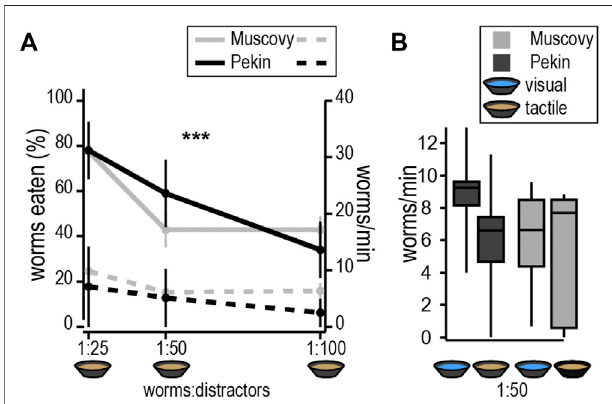
FIGURE1| Increasingdif fi cultyoftactileforagingtasks. (A) Performance oftarget consumption(mealwormseaten,solidline,lefty-axis)and non-target consumption (distractors eaten, dashed line, right y-axis) throughout tasks of increasing dif fi culty. Ratios of worms:distractors are calculated from weights in grams used in each task. Both Pekins and Muscovies consumed fewer worms as the ratio of distractors increased [F(2,39) = 8.5, p < 0.0001]. (B) Foraging-time corrected measurements (worms/min) showed no change as a function of the number of distractors. Conditions that allow ducks to see the worms did not improve task performance in either